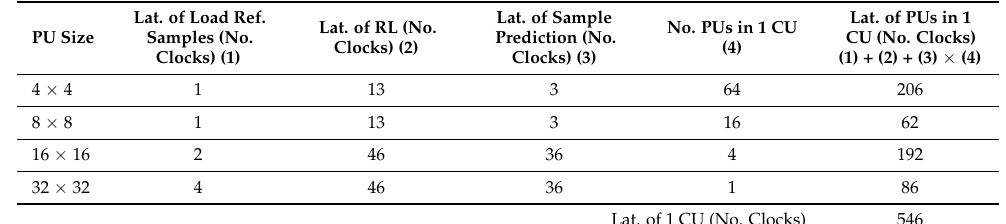
Table 3. Latency of PUs processing in a